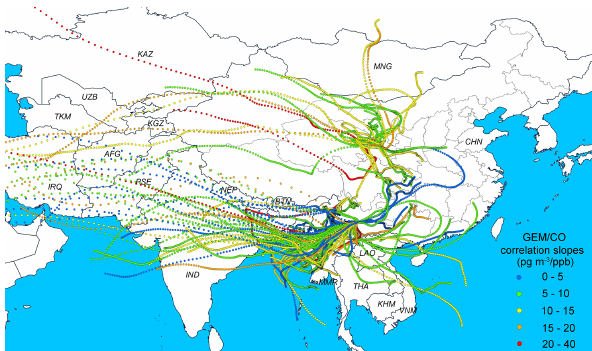
Figure 4. Correlation slopes of GEM/CO at the three monitoring sites and associated origins of